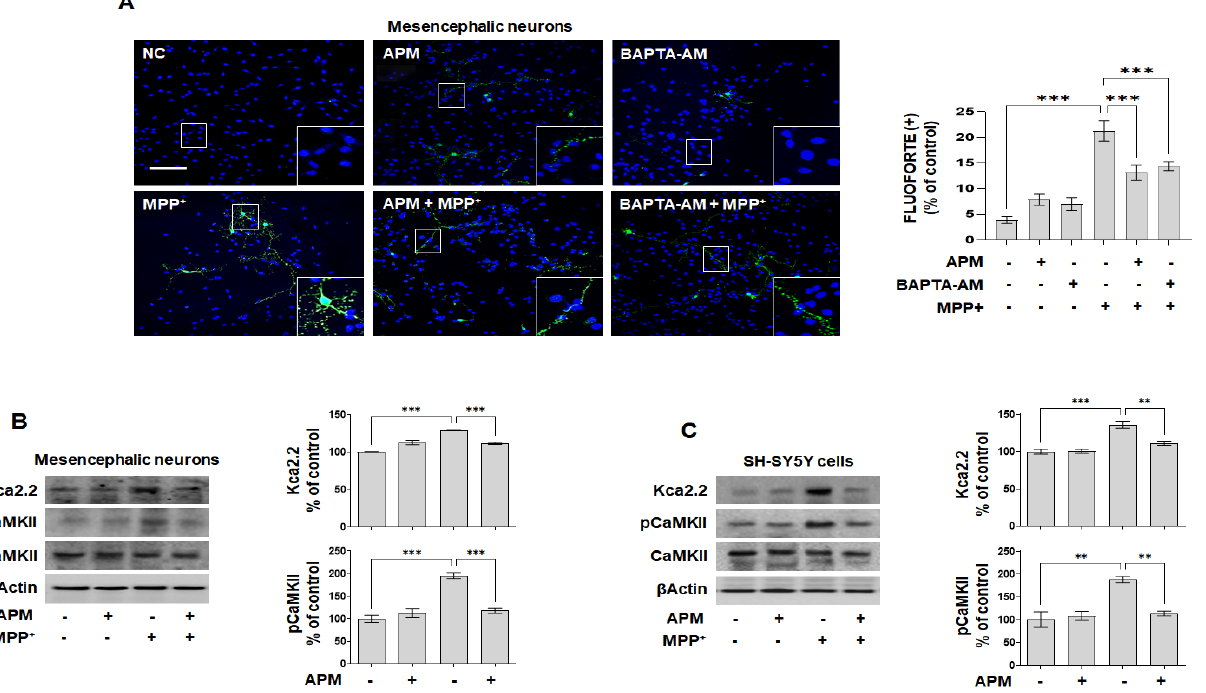
α SYN expression were protected by BAPTA-AM in SH-SY5Y cells (Figure S3a). These results suggested that APM could alter MPP + -induced neurotoxicity in dopaminergic neuronal cells by inhibiting Ca 2+ overload.